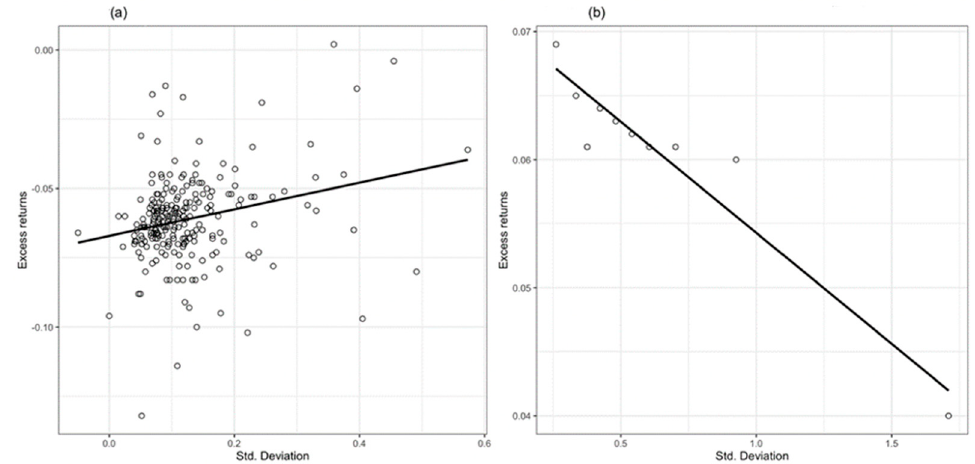
Figure 2. Relationship between standard deviation and excess returns for individual stocks ( a ) and portfolio of stocks ( b